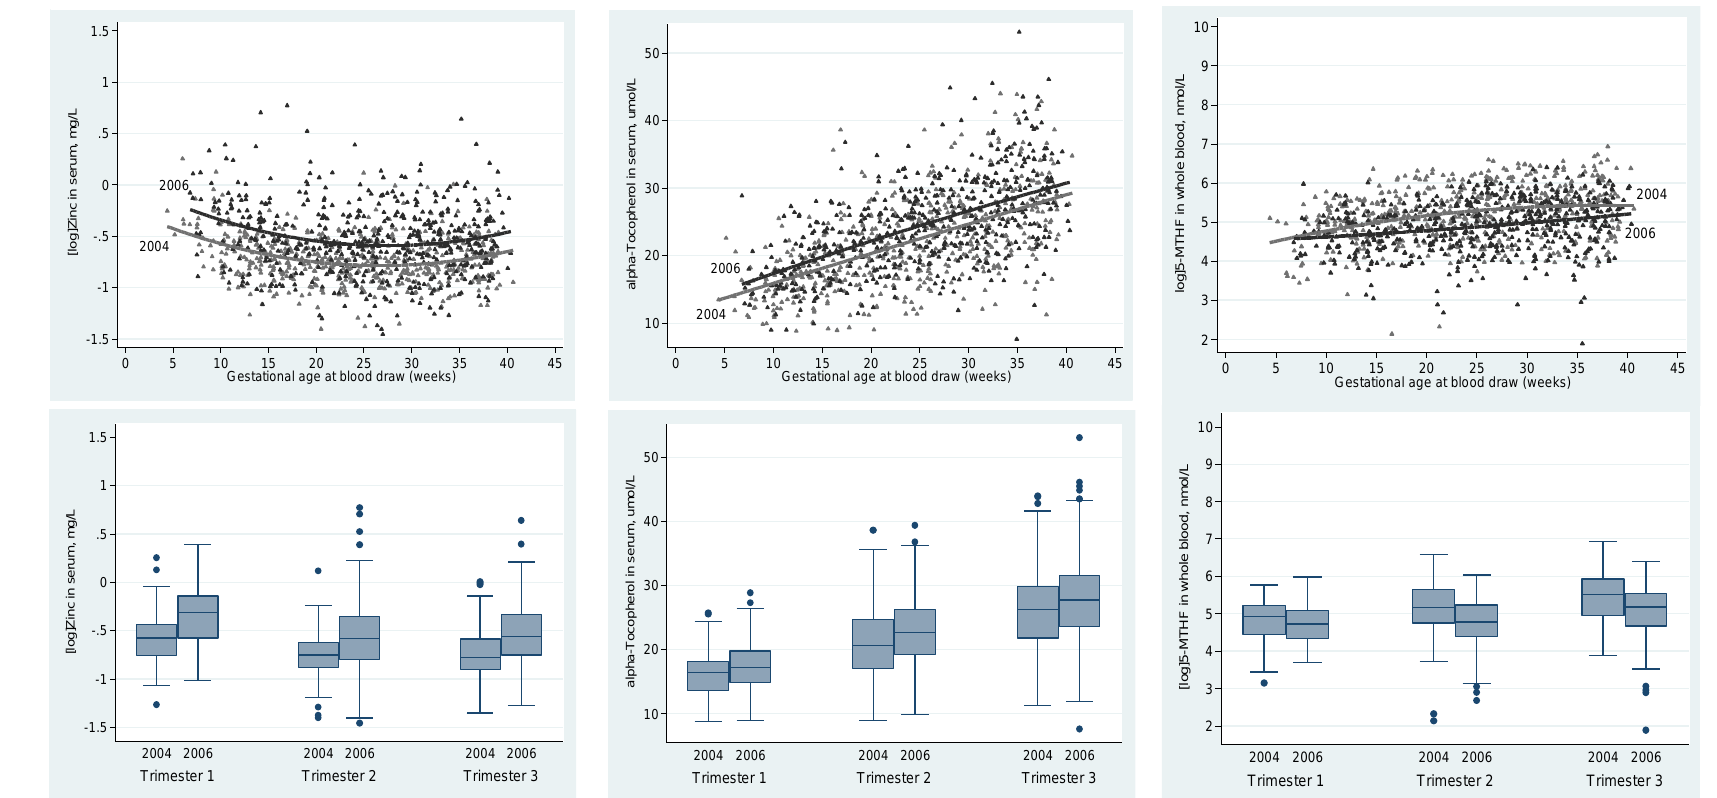
Figure A1. Serum zinc, α-tocopherol, and whole blood 5-methyltetrahydrofolate (5-MHTF) across gestation and by study year.